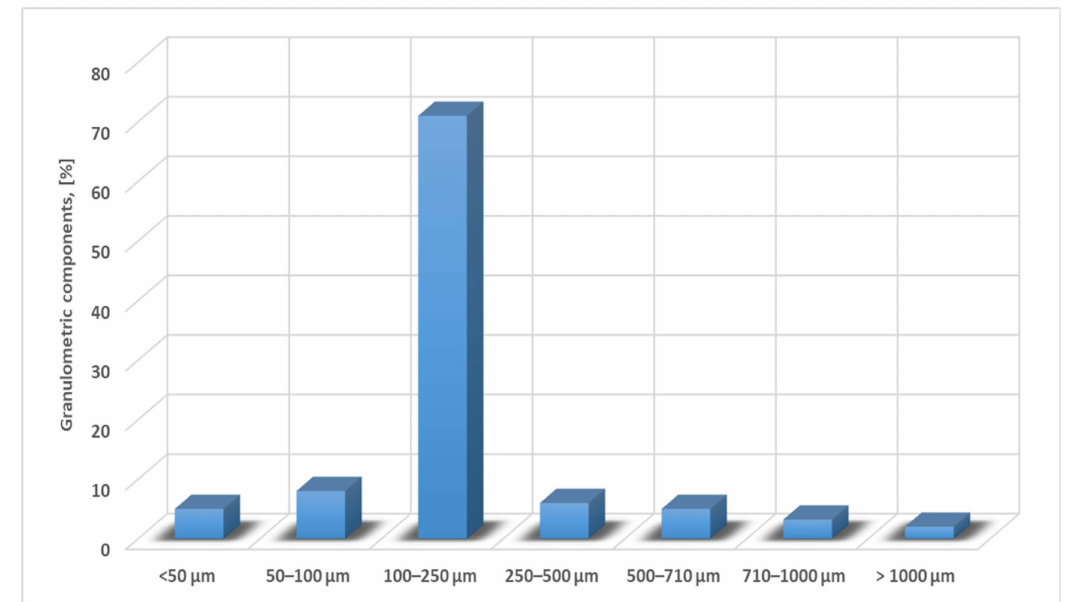
Figure 6. Particle size composition of ferrous